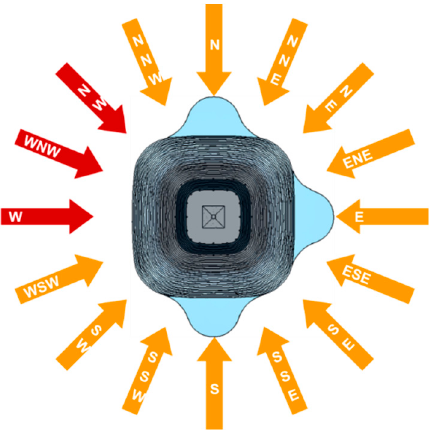
Figure 15. Wind directional sectors around the Lotte World Tower (top view) for wind resource mapping.